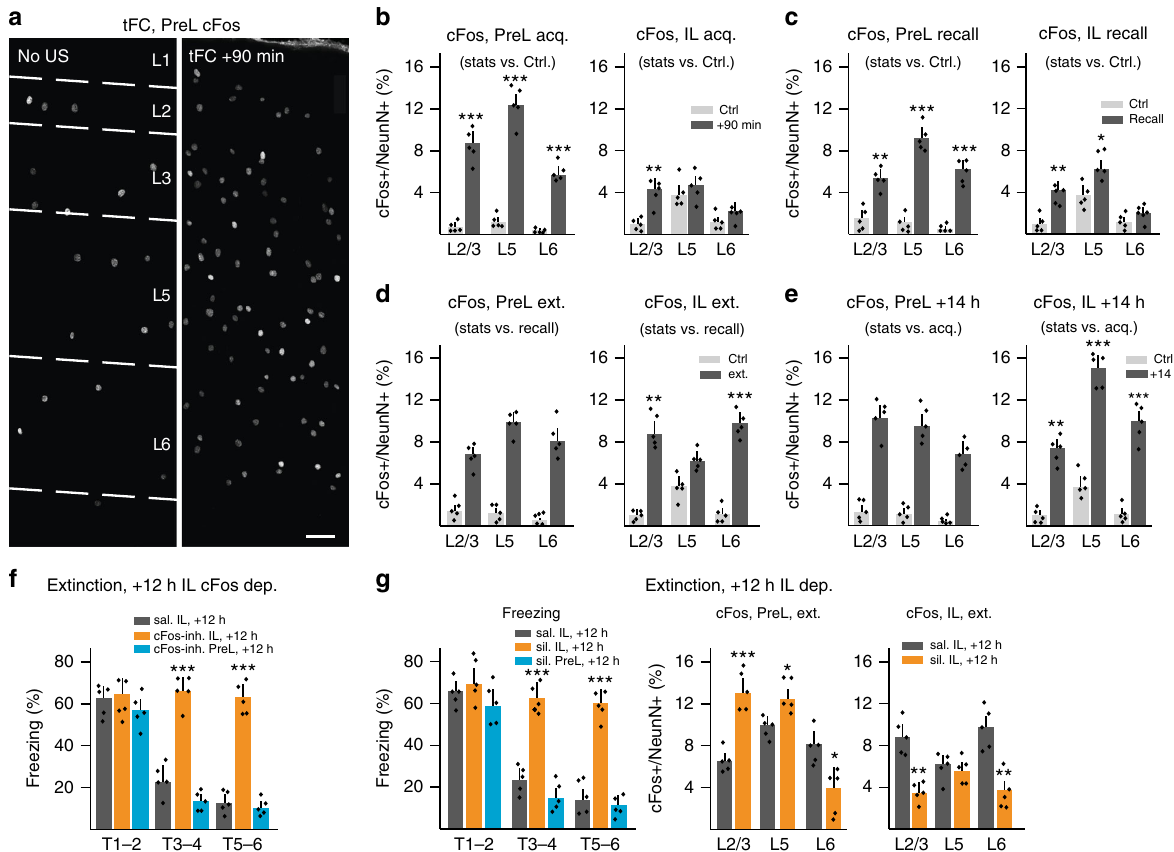
Fig. 6 Role of IL in extinction is setup 12 – 14 h postfear learning. a Representative images of PreL cFos immunoreactivity upon acquisition in control (CS